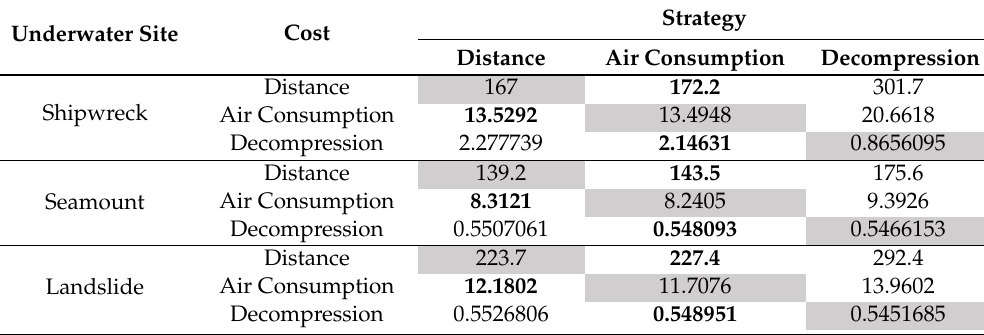
Table 3. The costs computed for each path with the tree